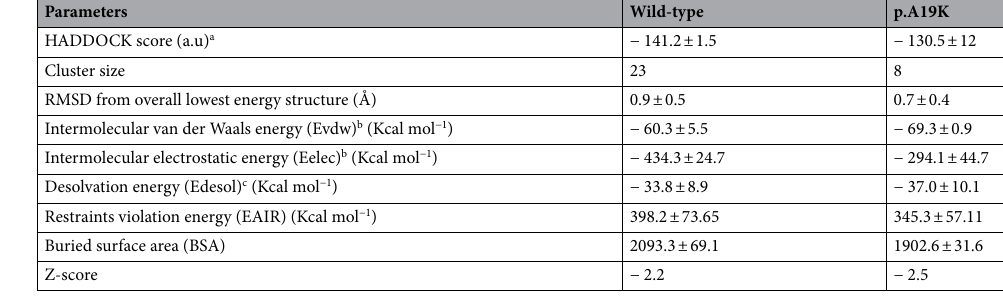
Table 2. Cluster statistics of the HADDOCK docking run calculated on the top 4 members of each cluster. RMSD root mean squared deviation, A19K Alanine substitution conserved Lysine at residue 19. a The